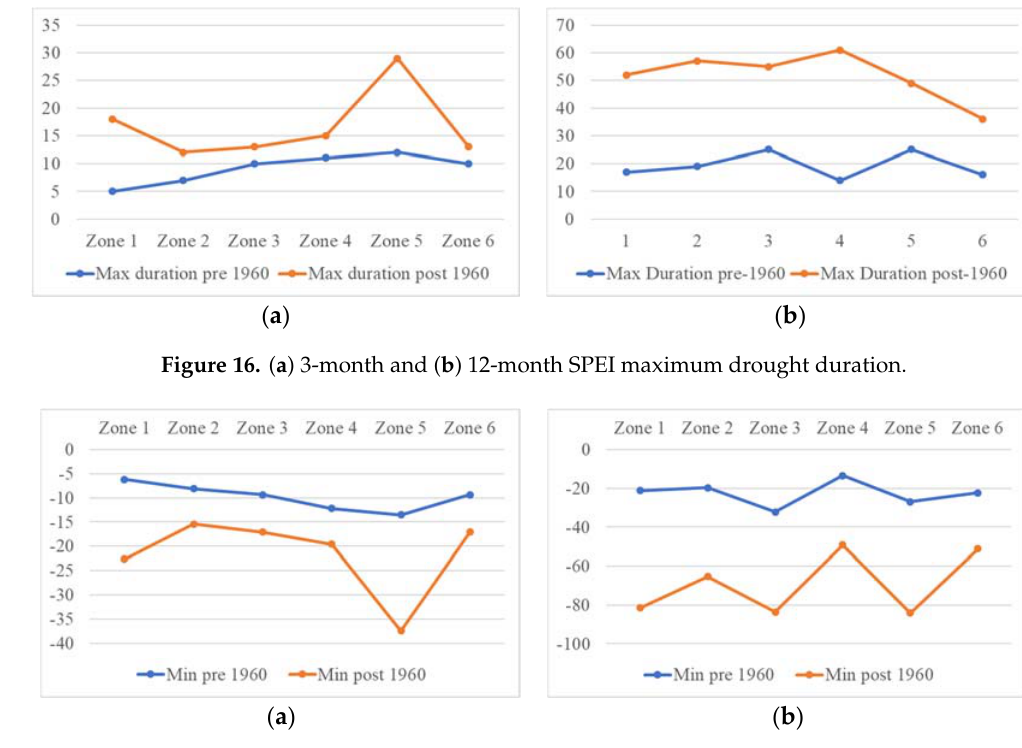
Figure 17. ( a ) 3 ‐ month and ( b ) 12 ‐ month SPEI minimum drought severity.